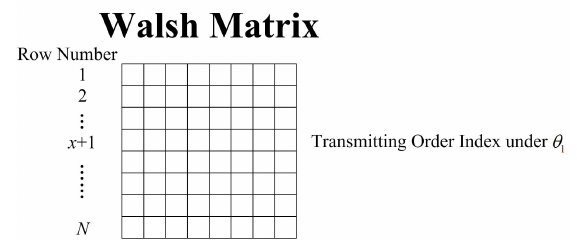
Figure 1. The schematic figure of the selected row in Walsh matrix for a given Doppler value.